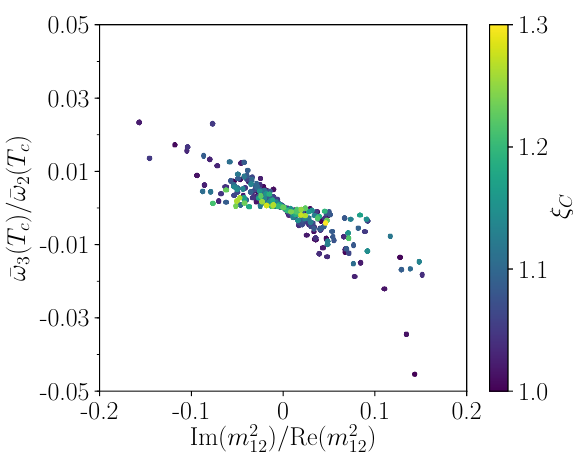
Figure 11 . Type II, H 1 = h : the value (cid:22) ! 3 ( T c ) = (cid:22) ! 2 ( T c ) at the critical temperature T c versus Im( m 2 ) = Re( m 2 ) = 0 at T = 0 for points with a strong PT. The colour code indicates the 12 12 6 size of (cid:24) c .